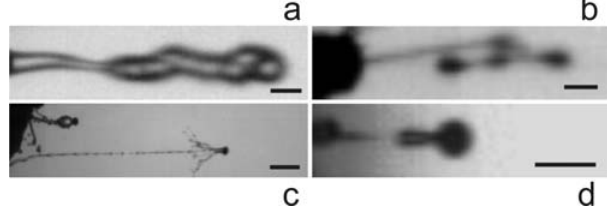
Figure 1. Single frames from high speed video recordings of spore discharge in four coprophilous fungi. a, Ascobolus immersus , with 8 ascospores discharged from ascus tip, 60 m s into the launch. b, Podospora anserina , with 4 ascospores harnessed by mucilaginous appendages, 96 m s after release from apex of fruiting body at left of frame. c, Pilobolus kleinii , sporangium with sap trailing behind, 0.8 ms after beginning of discharge. Undischarged sporangium at top of frame. d, Basidiobolus ranarum , single spore carrying portion of dehisced conidiophore, 24 m s into the launch. Scale bars, a, b, d, 50 m m, c, 1 mm. Frame rates a, 100,000 fps, b, 250,000 fps, c, 50,000 fps, d, 210,000 fps.